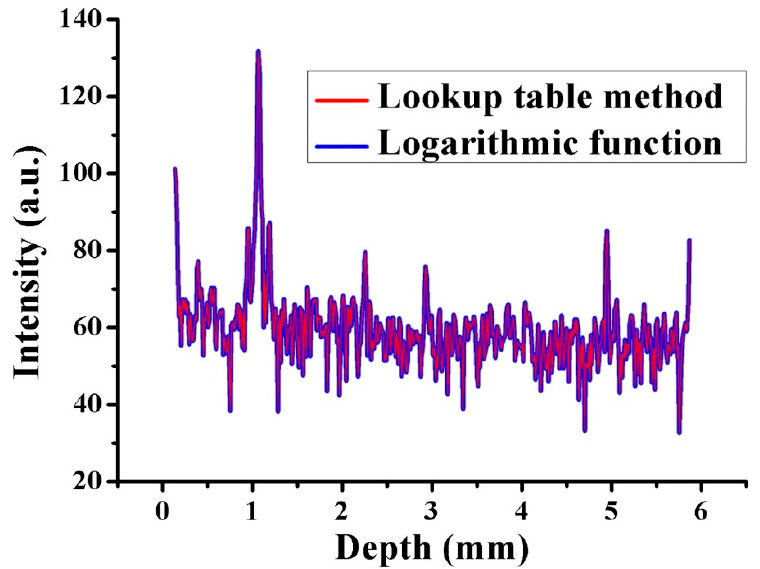
Figure 5. A-line signals reconstructed from logarithmic function ( blue ) and lookup table ( red ) calculation.